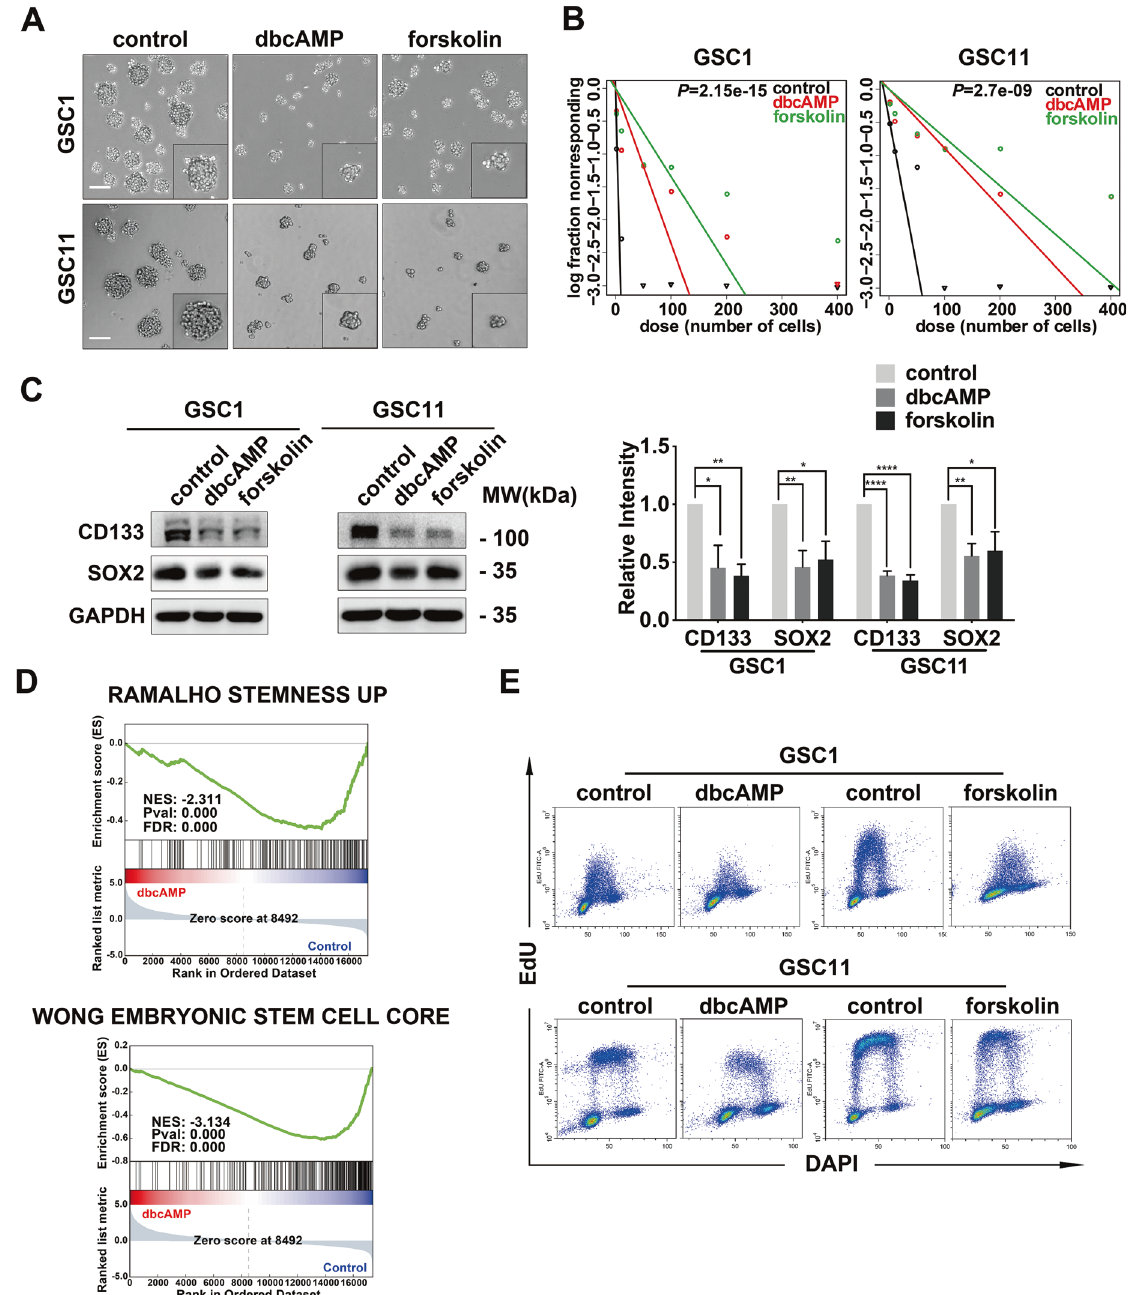
Fig. 2 Activation of cAMP compromises self-renewal and represses proliferation in GSCs. A Phase-contrast images of neurospheres formed by GSC1 and GSC11 cells after treatment with cAMP activators for 72 h. B Limiting dilution assays of GSC1 and GSC11 cells treated with dbcAMP and forskolin. C Western blot of CD133 and SOX2 protein in GSCs exposed to dbcAMP and forskolin (left) and quanti fi cation of protein bands (right). D GSEA analysis using the mRNA sequencing data. E Flow cytometry and EdU incorporation DNA histograms of GSCs before and after the treatment with dbcAMP and forskolin. (scale bar, 100 μ m; data are shown as the mean ± SD. N.S., not signi fi cant; *, p < 0.05; **, p < 0.01; ***, p < 0.001; ****, p < GSCs. Moreover, FH535 prevented the elevation of β -catenin by cAMP, we co-treated GSCs with dbcAMP and a potent inhibitor protein level mediated by cAMP activation (Fig. 4D and for β -catenin, FH535. Results from the neurosphere assay showed Supplementary Fig. S4C). FCM demonstrated that the combination that dbcAMP combined with FH535 dramatically decreased the treatment dramatically increased the level of MAP2 and TUJ1 in size of GSC1 and GSC11 neurospheres compared to monotherapy GSCs, compared to the monotherapy with dbcAMP (Fig. 4E). with either agent (Fig. 4A and Supplementary Fig. S4A). The Immuno fl uorescence staining con fi rmed that attenuated limiting dilution assay exhibited that β -catenin inhibition coop- β -catenin signaling signi fi cantly promoted the expression of erated with cAMP activation to repress the self-renewal in GSCs MAP2 as well as TUJ1 in GSCs after cAMP activation (Fig. 4F and (Fig. 4B). As shown in Fig. 4C and Supplementary Fig. S4B, Supplementary Fig. S4D). Similar fi ndings that reduction of FH535 signi fi cantly enhanced cAMP-induced proliferation arrest in